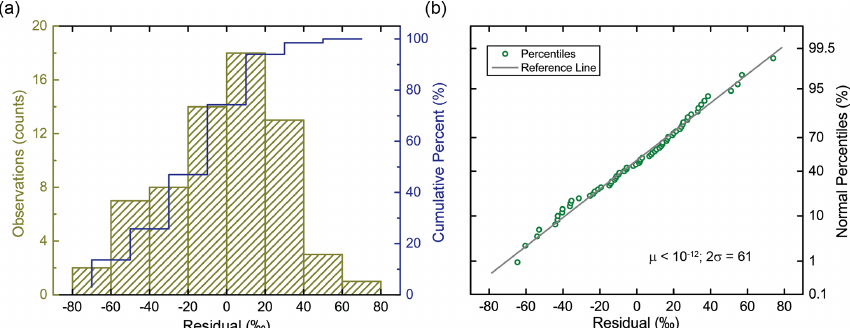
Figure 2. Histogram (a) and normal percentile plot (b) of the residuals. The reference line in panel (b) refers to the line of standard normal distribution.